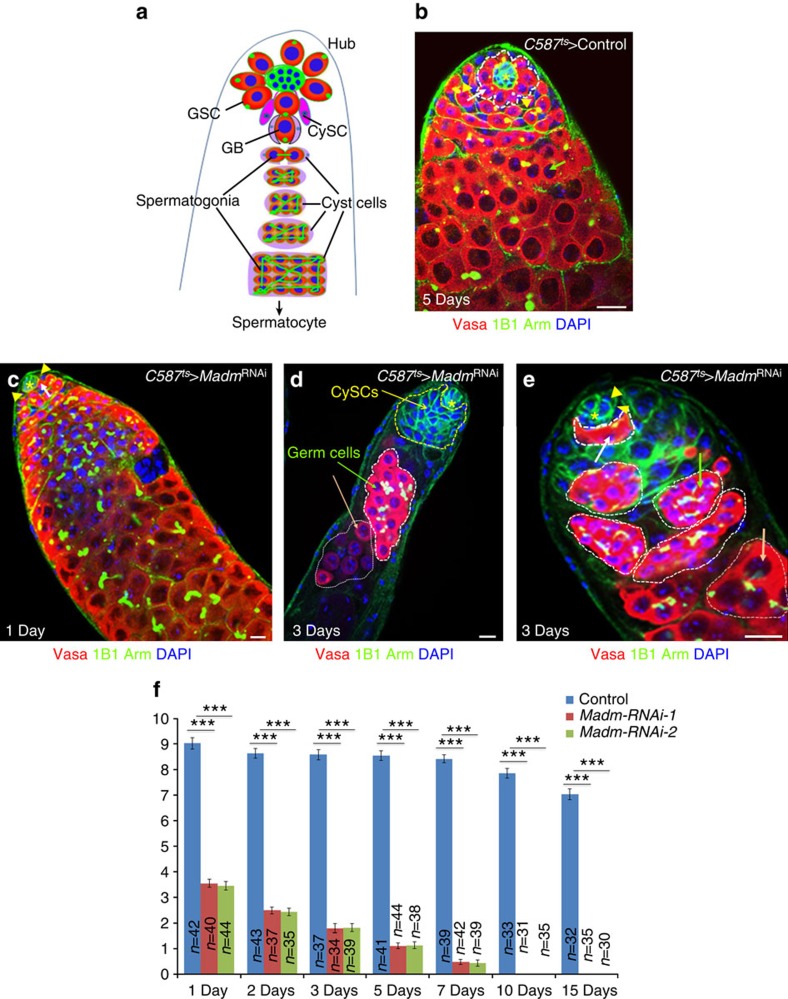
Madm functions in CySC to regulate GSC maintenance.(a) A schematic diagram of Drosophila adult testis. GSCs and GBs (gonialblasts) contain the spherical spectrosomes (green dots), while spermatogonia and spermatocytes contain branched fusomes (green lines). GSCs are encysted by two CySCs (magenta). GBs and other germ cells (red) are encapsulated by cyst cells (lavender). (b–e) The confocal section of the testis apex from C587ts>control (b), and C587ts>MadmRNAi−1 (BL31644; c–e) males after shifting the temperature from 18° to 29 °C for 1 to 15 days as adult flies. In control testis (b, 5 days at 29 °C, n=41) contain a rosette of GSCs around the hub (white dotted lines with one GSC is highlighted by an arrow), and CySCs are located away from the hub (yellow arrowhead). In C587ts>MadmRNAi testes (c, 1 day, n=40; (d,e), 3 days, n=39), the number of GSCs are gradually lost from the niche and differentiated (highlighted by white dotted lines in d,e), and CySCs moved into the niche (highlighted by yellow dotted lines in d). The testes were stained with antibodies against Vasa (red, marks all germ cells including GSCs), 1B1 (green, marks spherical spectrosomes and branched fusomes), Arm (green, hub cells at the tip). DAPI (blue) stains nuclei. Asterisks indicate hub cells. White arrows near hub indicate GSC. Green arrows (in d,e) and orange arrow (d,e) away from hub with white dotted lines indicate spermatogonial cells and spermatocytes, respectively. (f) A bar graph showing the number of GSCs per testis in C587ts>control, C587ts>MadmRNAi−1 (BL31644) and C587ts>MadmRNAi−2 (v27346) flies. Flies were cultured from 1 to 15 days at 29 °C before staining with antibodies against Vasa, 1B1 and Arm. Statistical significance determined by Student's t-test, ***P<0.0001. All values are mean±s.e.m. Scale bar, 10 μm (b–e).